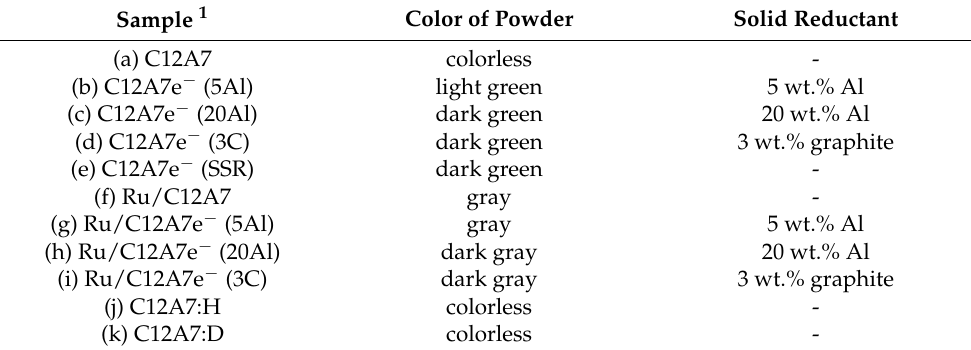
Table 1. C12A7e − samples studied in this